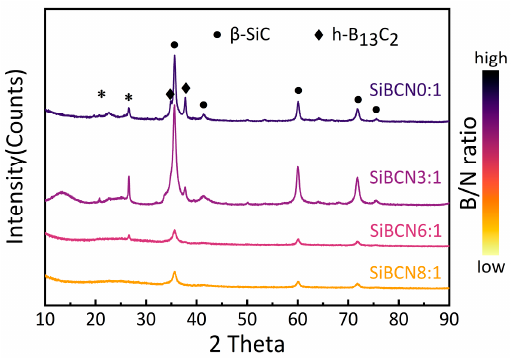
Figure 3. XPS spectra of B 1s of SiBCN x:y at 1000 °C and 1600 °C.